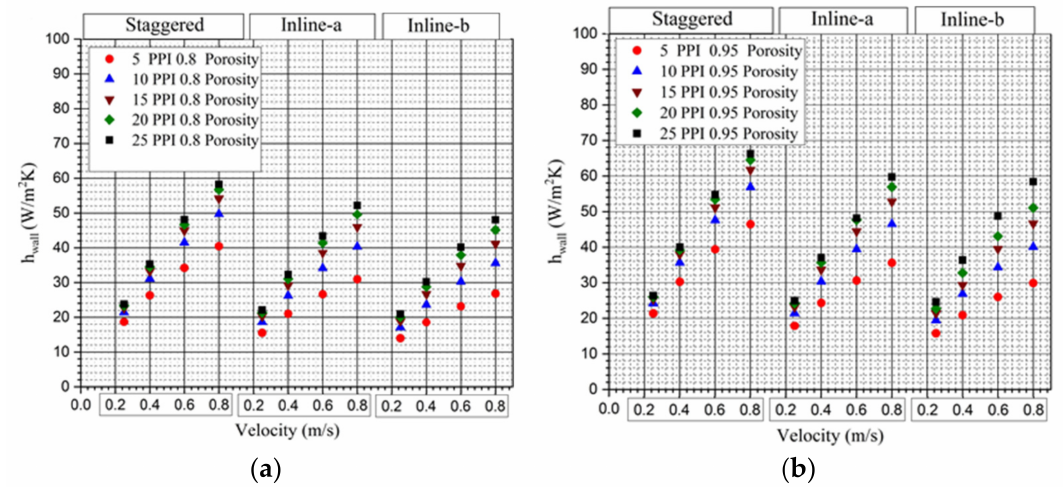
Figure 16. ( a ) Variation of average wall heat transfer coefficient for 5 PPI (pore- density/mesh-size) wire mesh samples of different porosity for all three stacking scenarios. ( b ) Variation of average wall heat transfer coefficient for 25 PPI (pore-density/mesh-size) wire mesh samples of different porosity for all three stacking scenarios.